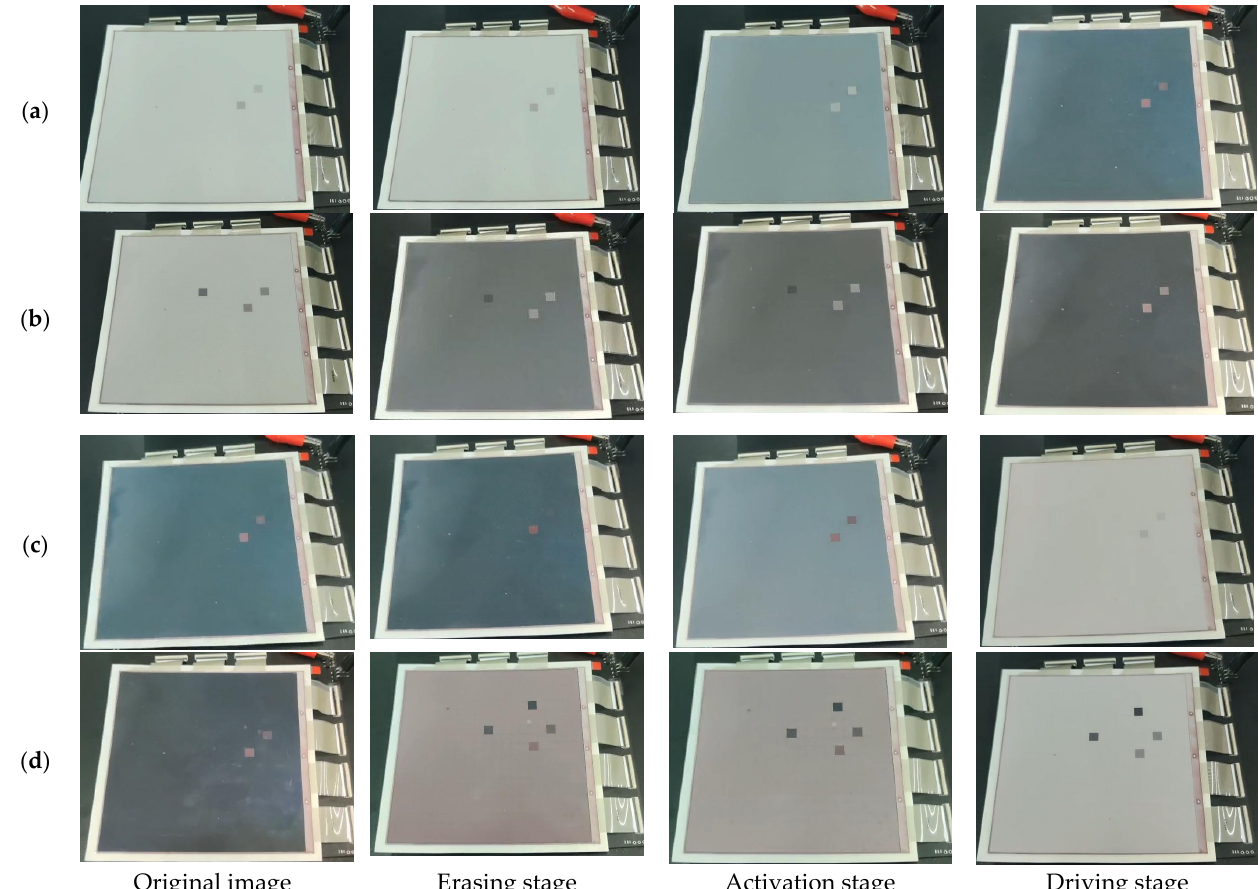
Figure 8. The grayscale conversion process of the three-color EPD. ( a ) It was driven by the traditional driving waveform and the target grayscale was black. ( b ) It was driven by the proposed driving waveform and the target grayscale was black. ( c ) It was driven by the traditional driving waveform and the target grayscale was white. ( d ) It was driven by the proposed driving waveform and the target grayscale was white.